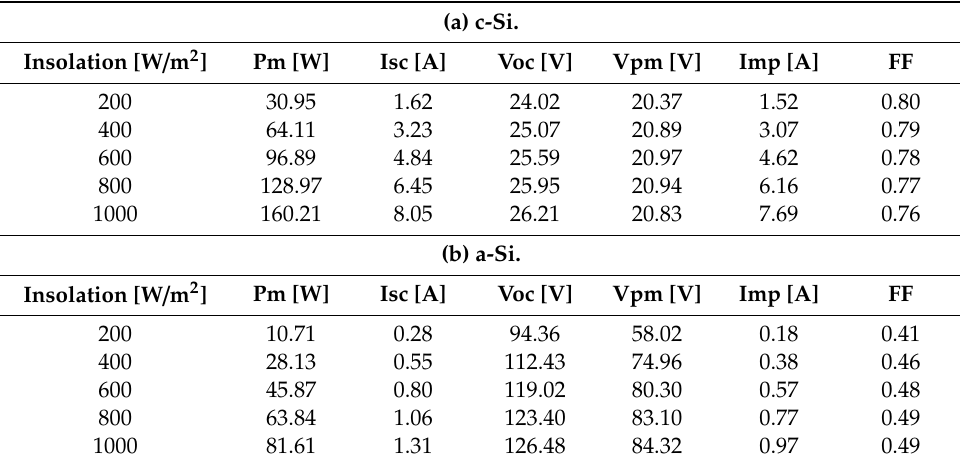
Figure 1. Configuration used to measure the PV modules: ( a ) Light source; ( b ) Mechanical part; ( c ) Control part. The module photo in ( b ) is not the sample used in the experiment. Table 2. Characteristics of the electric power output of the PV modules (Test conditions: cell temperature, 25 ◦ C; wind speed, below 1 m / s; irradiation, class AAA